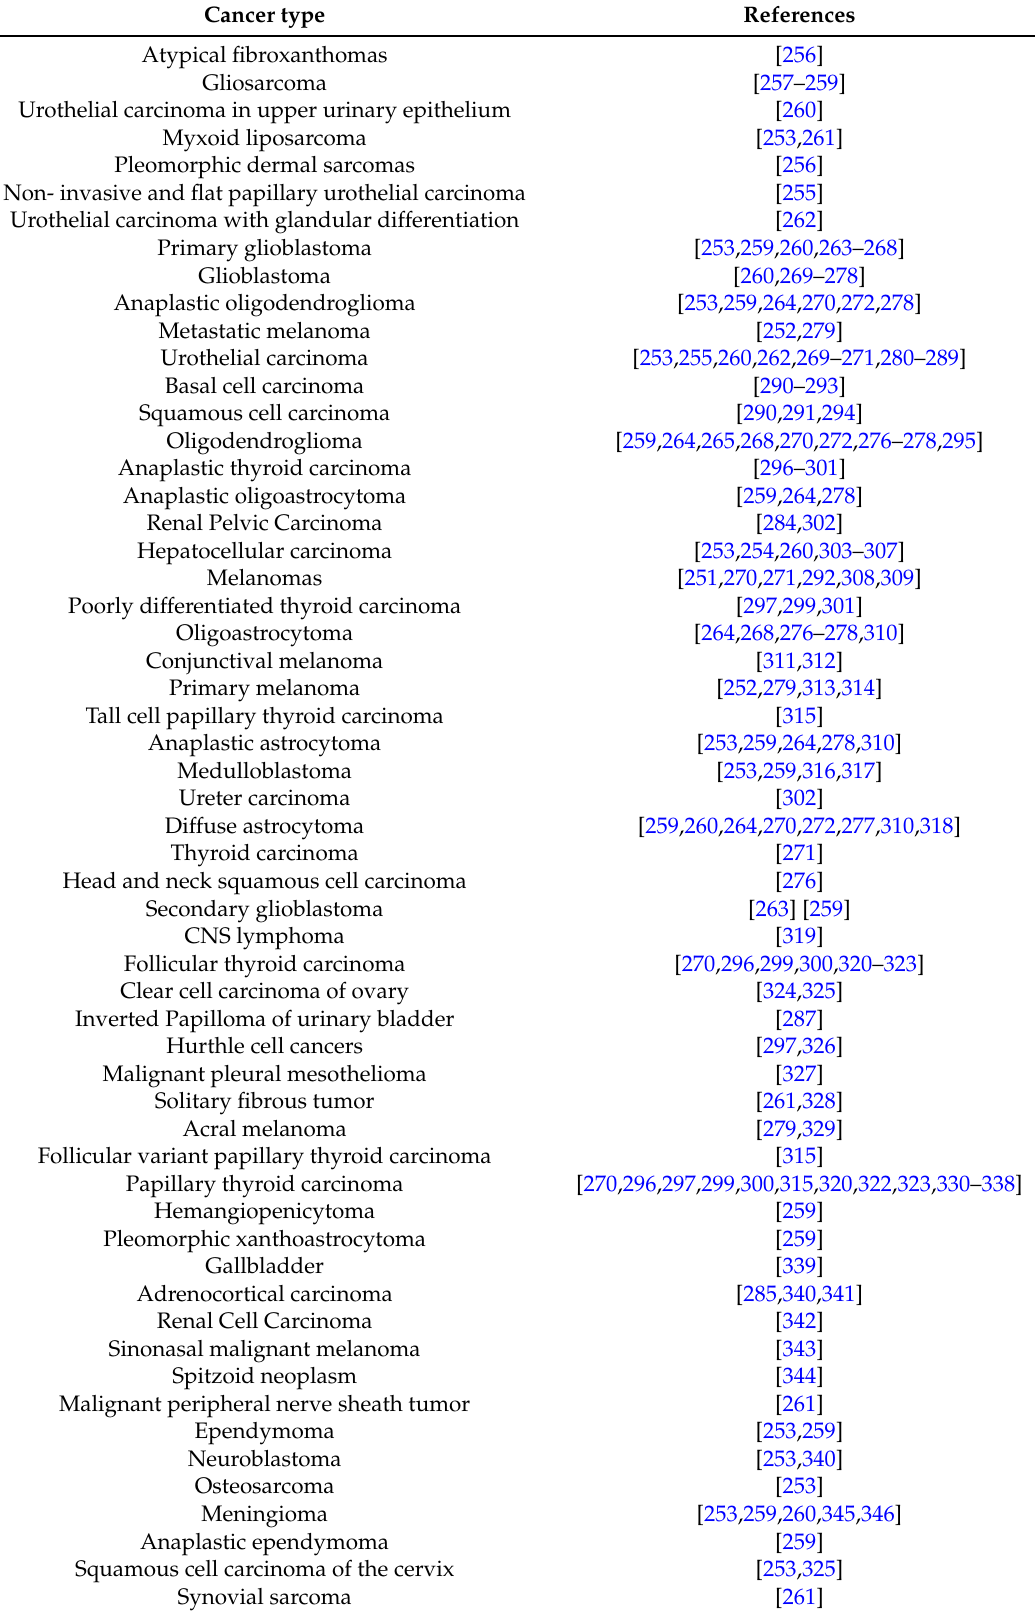
Table 3. List of publications reporting hTERT promoter mutation frequency in the various cancer